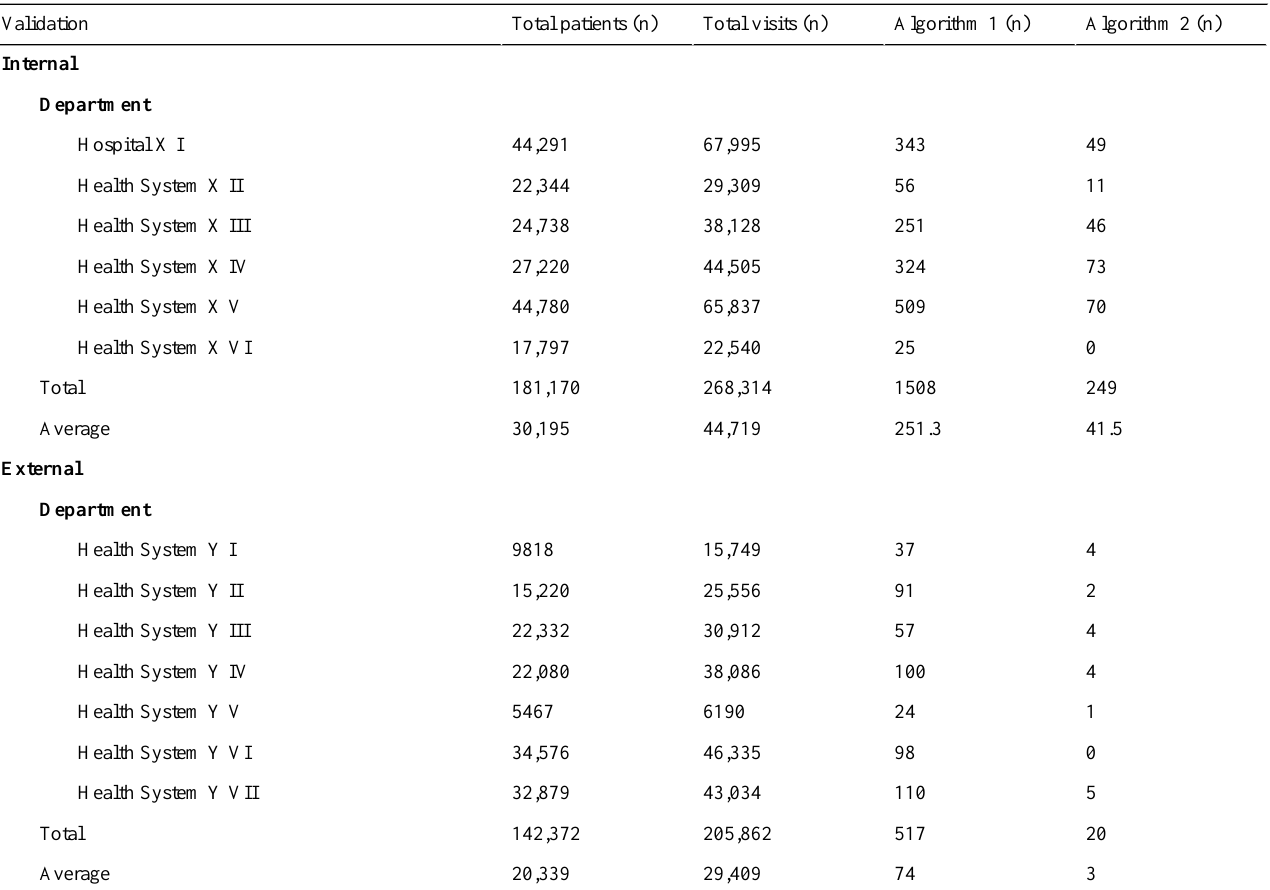
Table 4. Annual volume of emergency department (ED) visits meeting phenotype criteria (November 1, 2017, to October 31, 2018, ED discharges only).